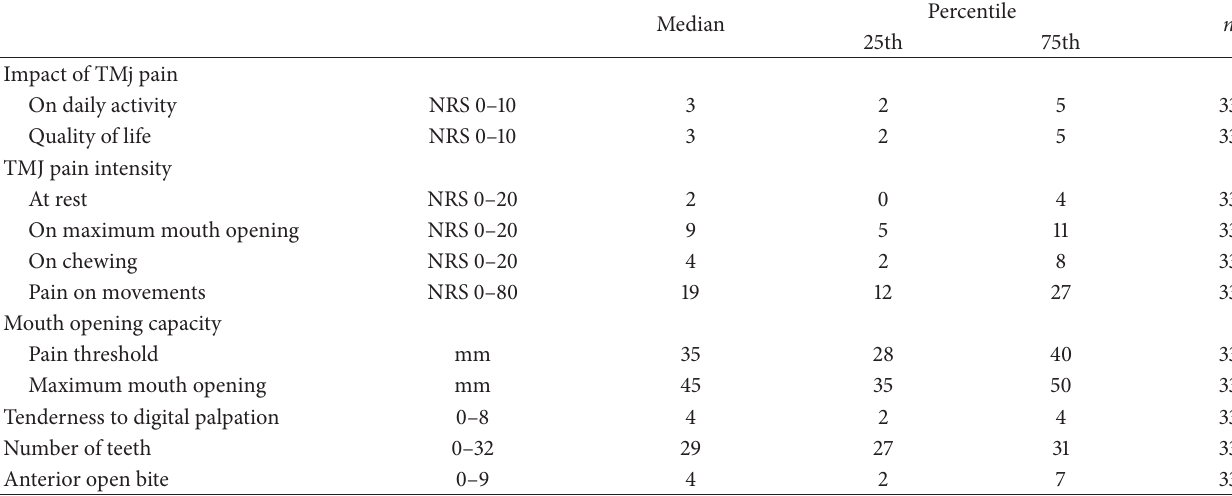
Table 2: Clinical findings in 33 patients with temporomandibular joint (TMJ) involvement of rheumatoid arthritis.